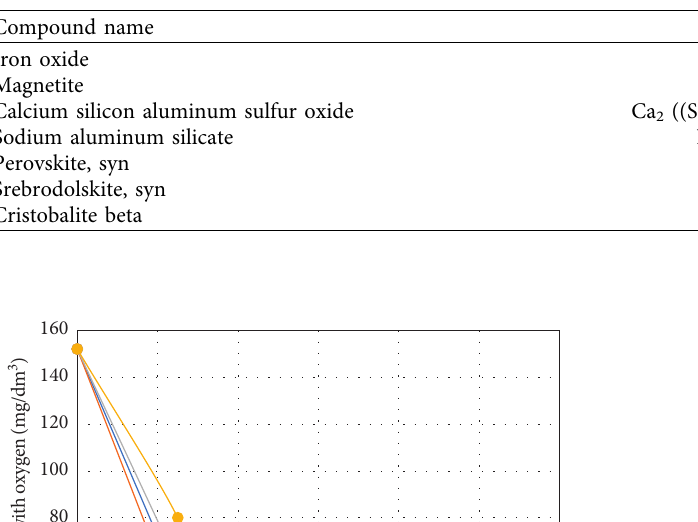
Table 2: Phase composition of the cake of JSC Pavlodar Aluminum Plant.